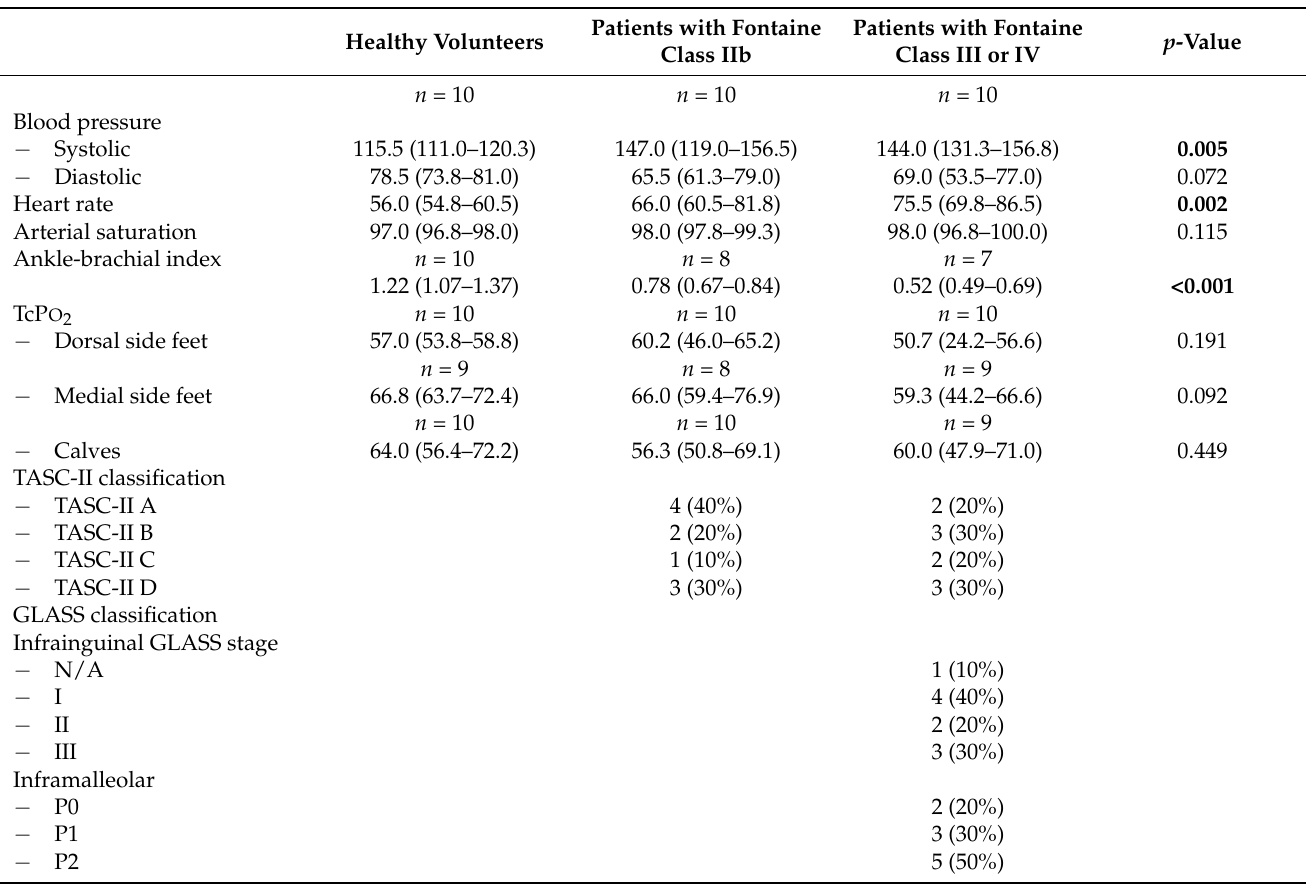
Table 2. Blood pressure, heart rate, saturation, ABI, TcPO2, TASC-II classification, and GLASS classification of healthy volunteers, patients with Fontaine class IIb, and patients with Fontaine class III or IV. Patients with Fontaine Patients with Healthy Volunteers Class IIb